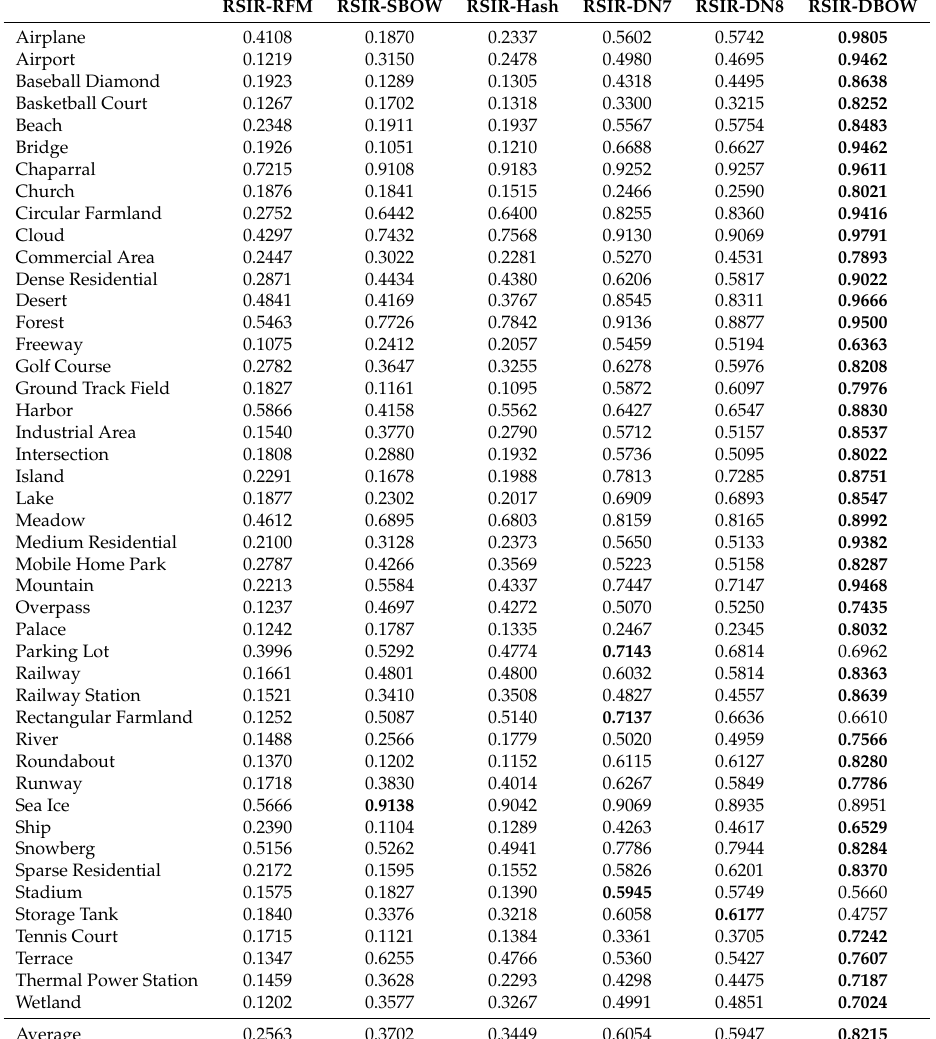
Table 6. Retrieval precision of different RSIR methods across 45 semantic categories in ImgDB4 counted by the top 20